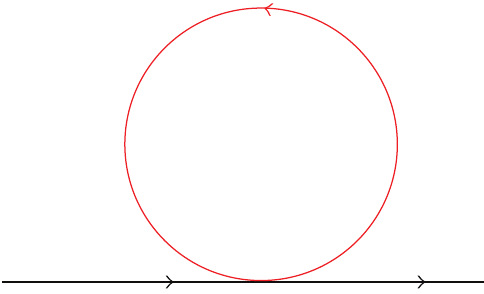
Figure 2: The particular solution to S (cid:2) x,y (cid:3) .